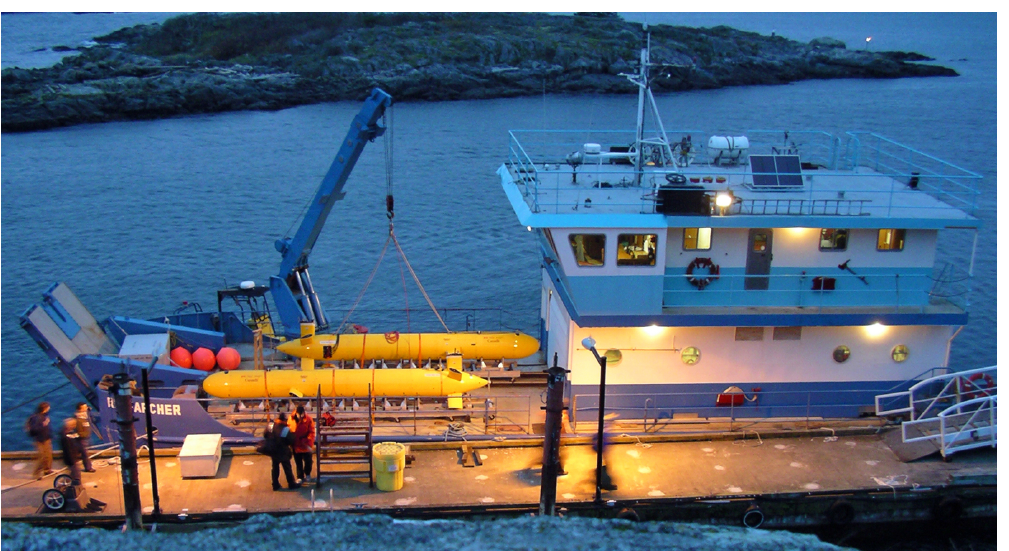
Figure 5. Two ISE Arctic Explorer AUV aboard ISE’s R/V Researcher Nanoose Bay, BC, Canada during sea trials in 2010. The ISE Arctic Explorer AUV were built and deployed in the Canadian Arctic to conduct bathymetric surveys to support Canada’s claim to the extent of its continental shelf under the United Nations Law of the Sea Convention. Image Credit: International Submarine Engineering Ltd. (Port Coquitlam, BC, Canada) Reproduced with permission.